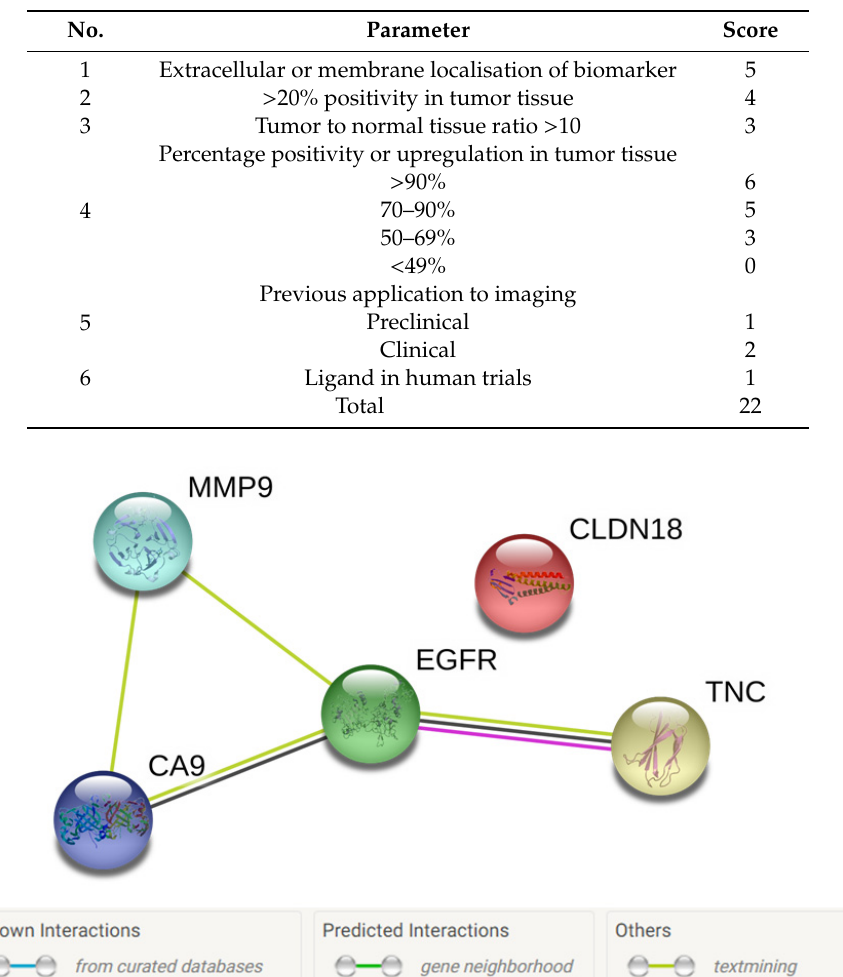
Table 1. Potential targetable biomarkers for theranosis (TASC-T) scoring criteria.